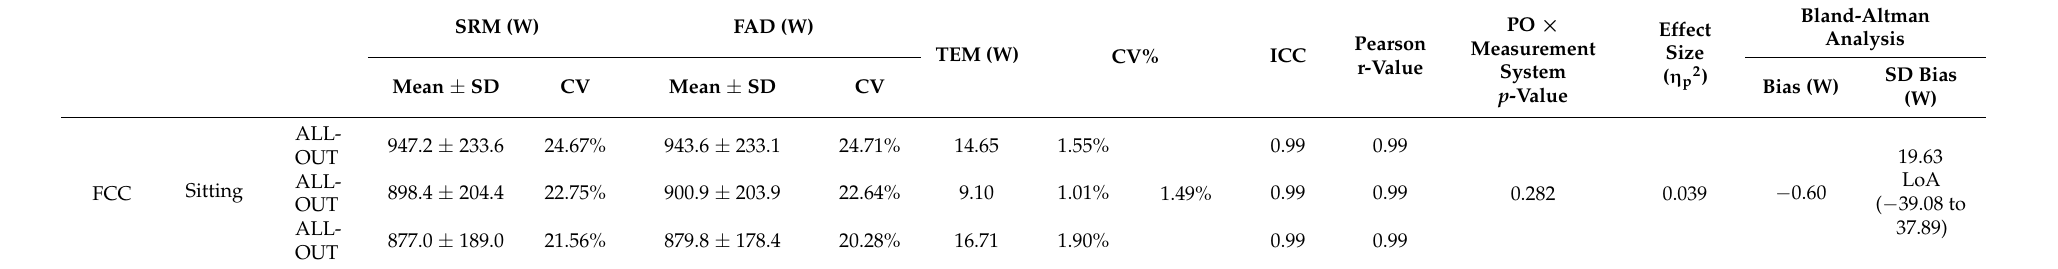
Table 2. Analysis of the peak power output (PPO) registered by the SRM and the FAD power meters during all-out